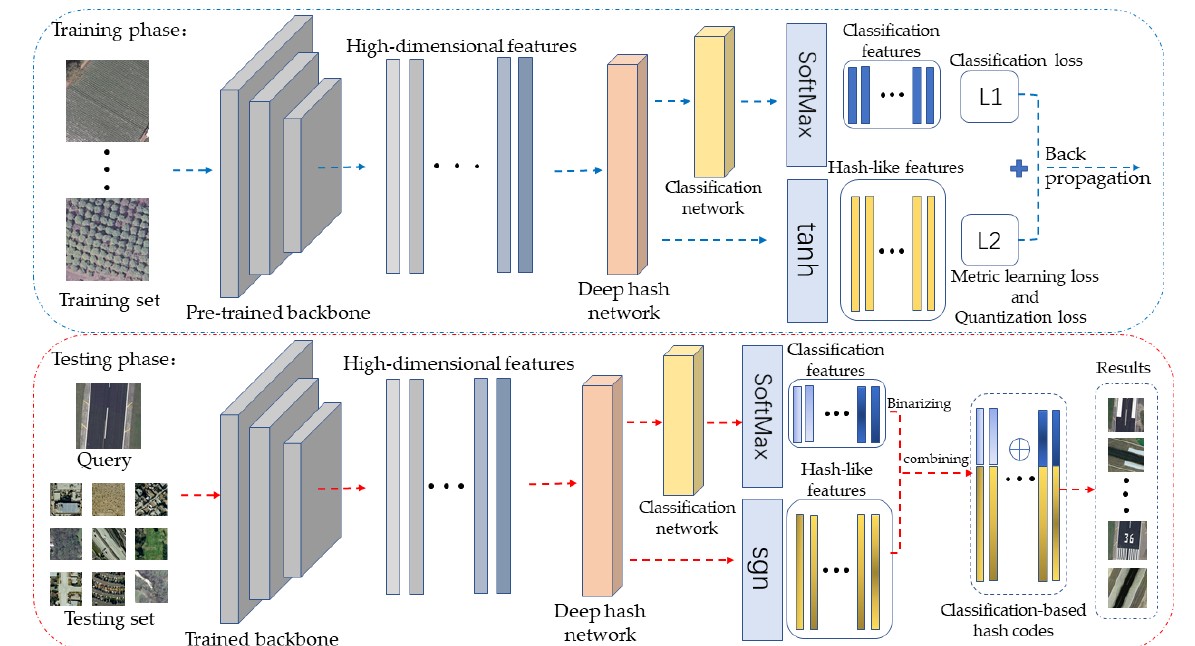
Figure 2. The framework of our DHCL method. The above part is the training process. First, a pretrained backbone is introduced to extract high-dimensional features. Then, a deep hash network is used to map the high-dimensional features into low-dimensional hash-like features. Furthermore, we input the low-dimensional hash-like features into a classifier to obtain the classification feature, which is generated after the softmax function. Finally, we calculate classification loss, metric-learning loss and quantization loss and optimize the network by back-propagation. The below part demonstrates the testing process, where the query image and the test image set are fed into the well-trained backbone and deep hash network to obtain low-dimensional hash-like features. They are entered into the classification network to obtain the classification labels. The low-dimensional hash-like features are quantized to obtain the hash code, and the classification labels are binarized and combined with the hash code to obtain the final hash code for retrieval.